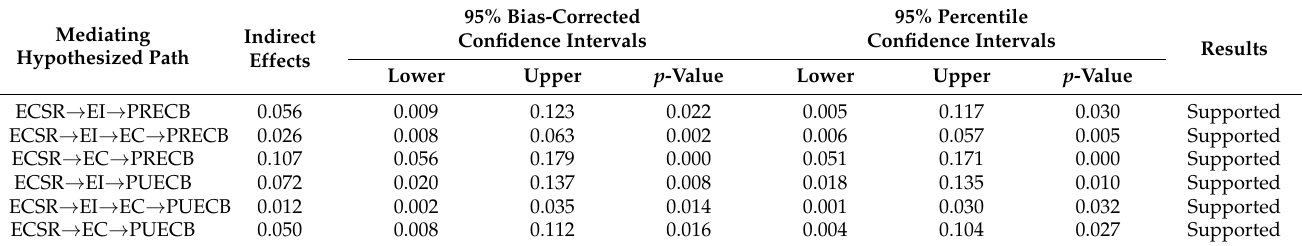
Table 5. Mediation test